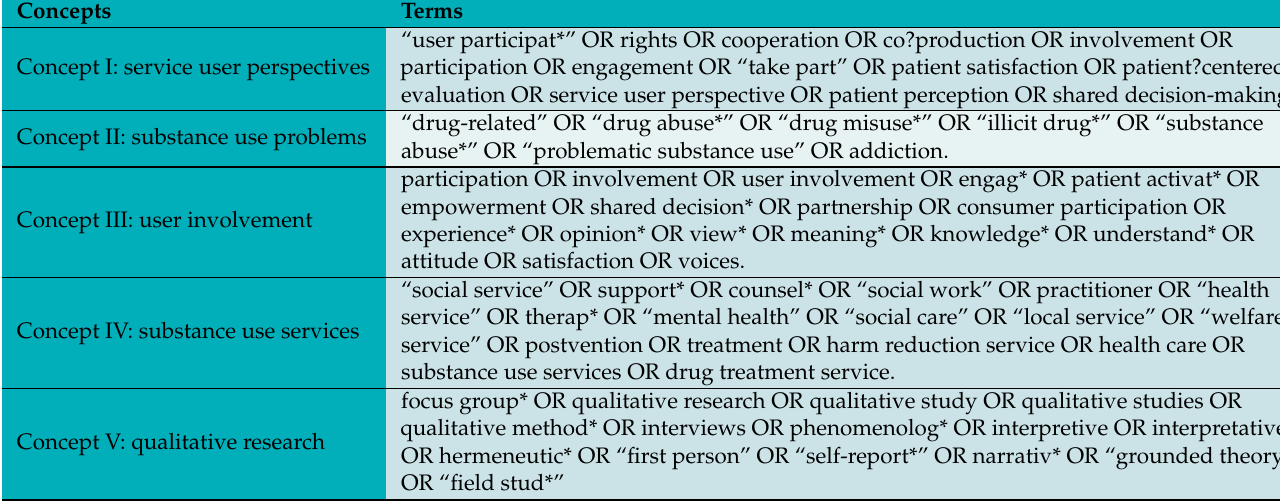
Table 1. Concepts and terms in the search